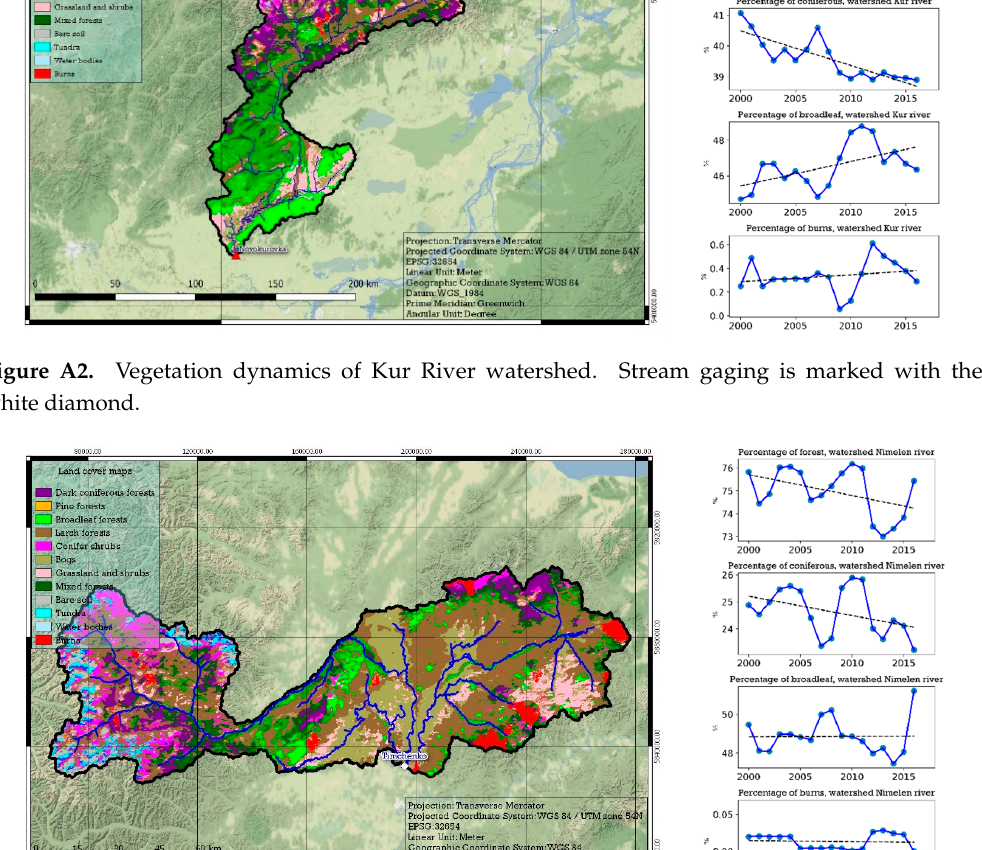
Figure 16. Vegetation dynamics of Manoma River watershed. Stream gaging is marked with the white diamond. References 1.